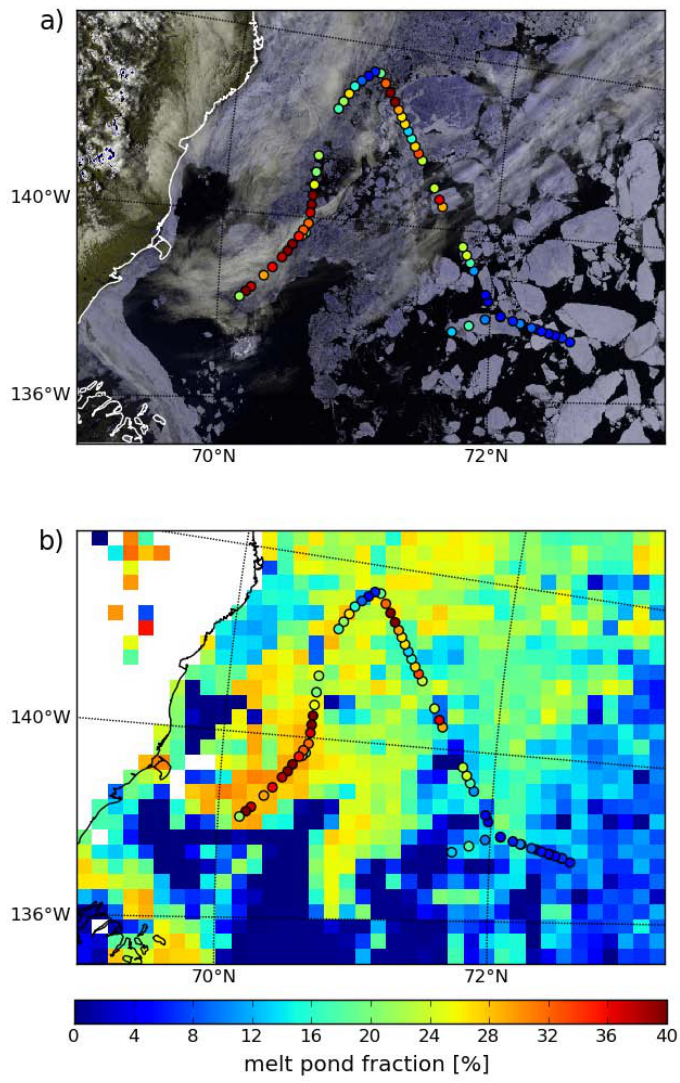
Fig. 10. (a) Spatial overlay of MELTEX melt pond results (dots) on a true color composite of MODIS level 1B data from 7 June 2008, 21:25UTC. (b) MELTEX melt pond results (dots) from 7 June 2008 overlaid on MODIS relative melt pond fractions from mainly 7 June 2008 (detailed description in the